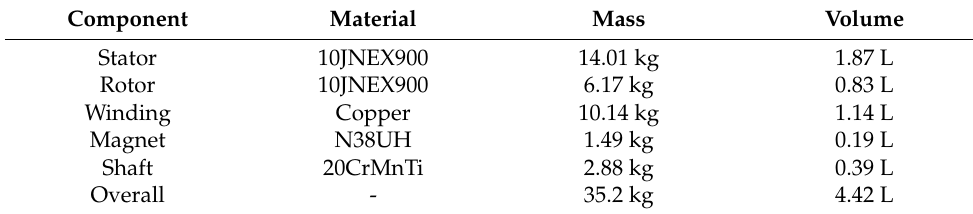
Table 6. Ver2.0 motor’s space dimensions.